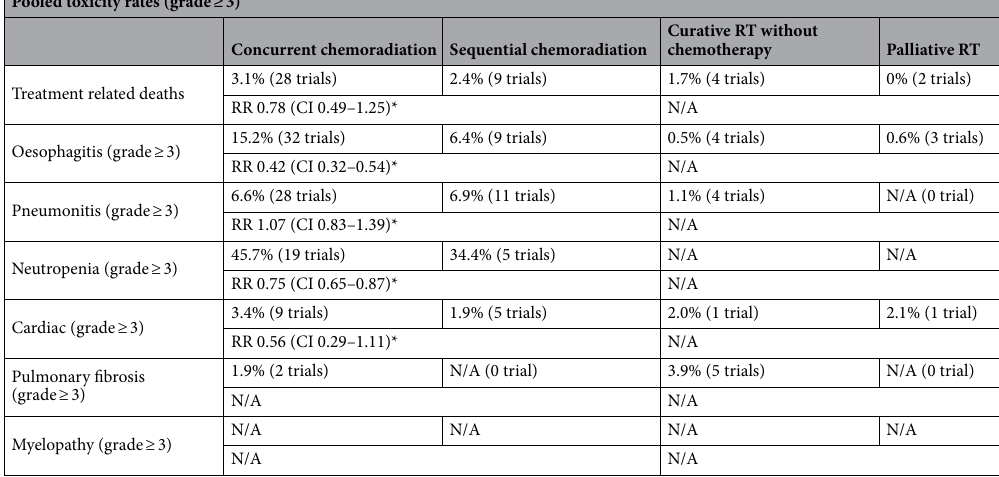
Table 3. Summary table of the pooled grade ≥ 3 toxicity rates. RR* Risk ratio of sequential versus concurrent, CI Confidence interval, N/A Not applicable.